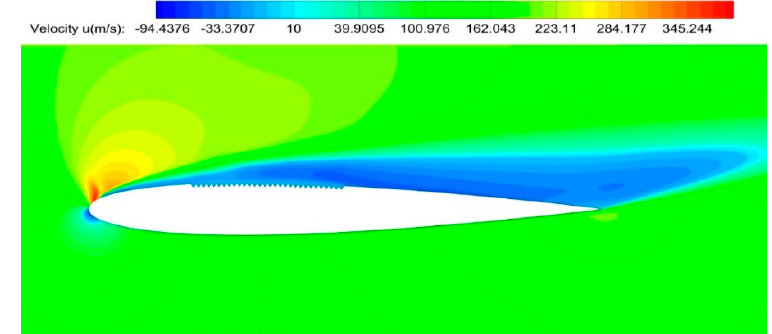
Figure 25. t = 1 s, velocity distribution of NACA0012 airfoil with grooves on the suction side at a 19° angle of attack.